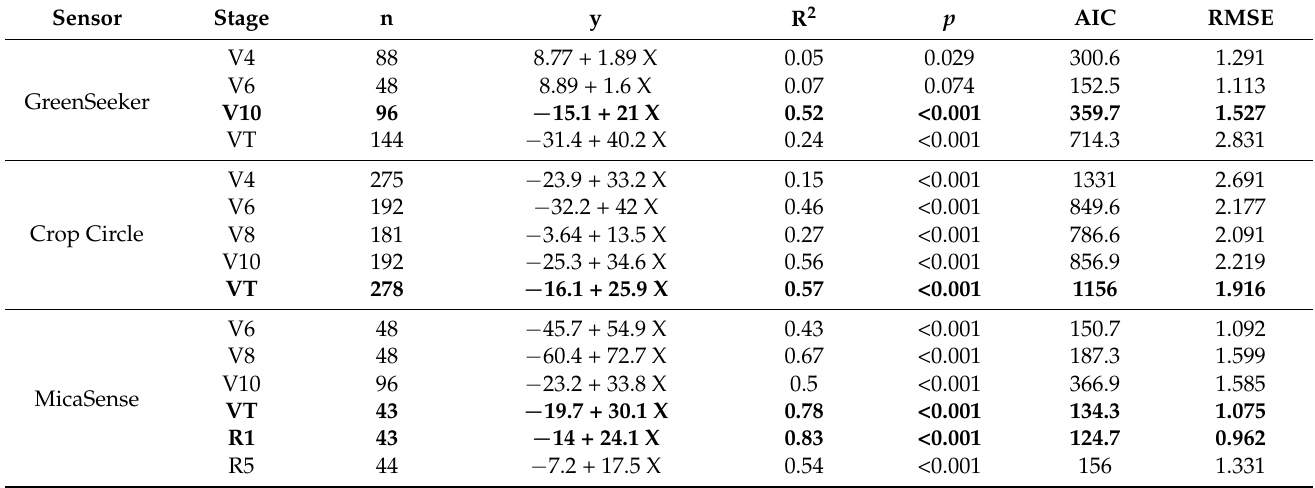
Table 7. Stage comparison between the GreenSeeker, Crop Circle, and MicaSense sensors. The best fit stage based on R 2 , AIC, and RMSE is